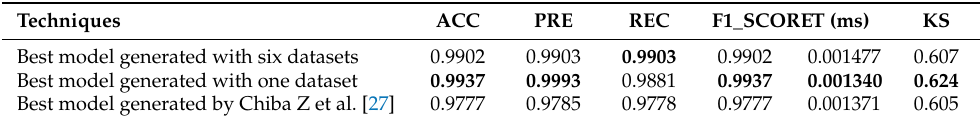
Table 13. Performce of best model generated of different methods.